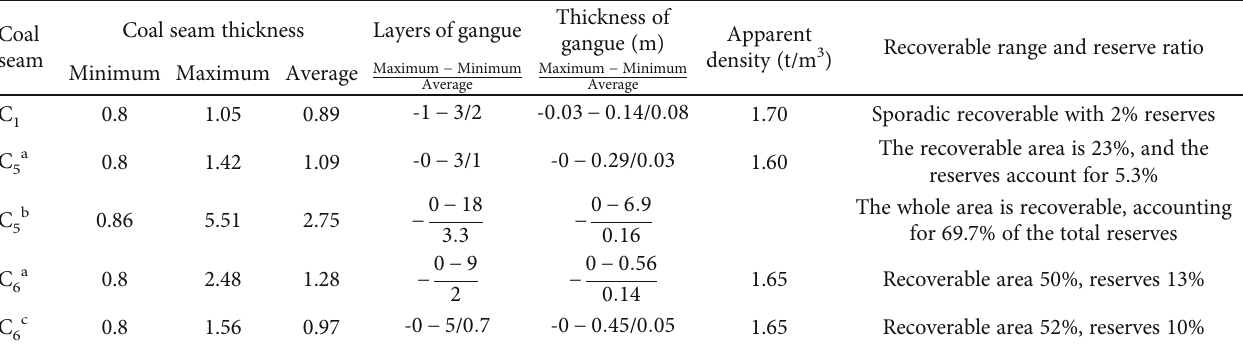
Table 1: Coal seam characteristics.